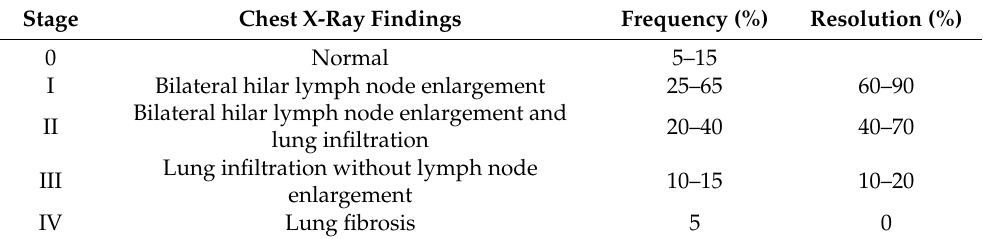
Table 1. Scadding classification of lung involvement from sarcoidosis at chest